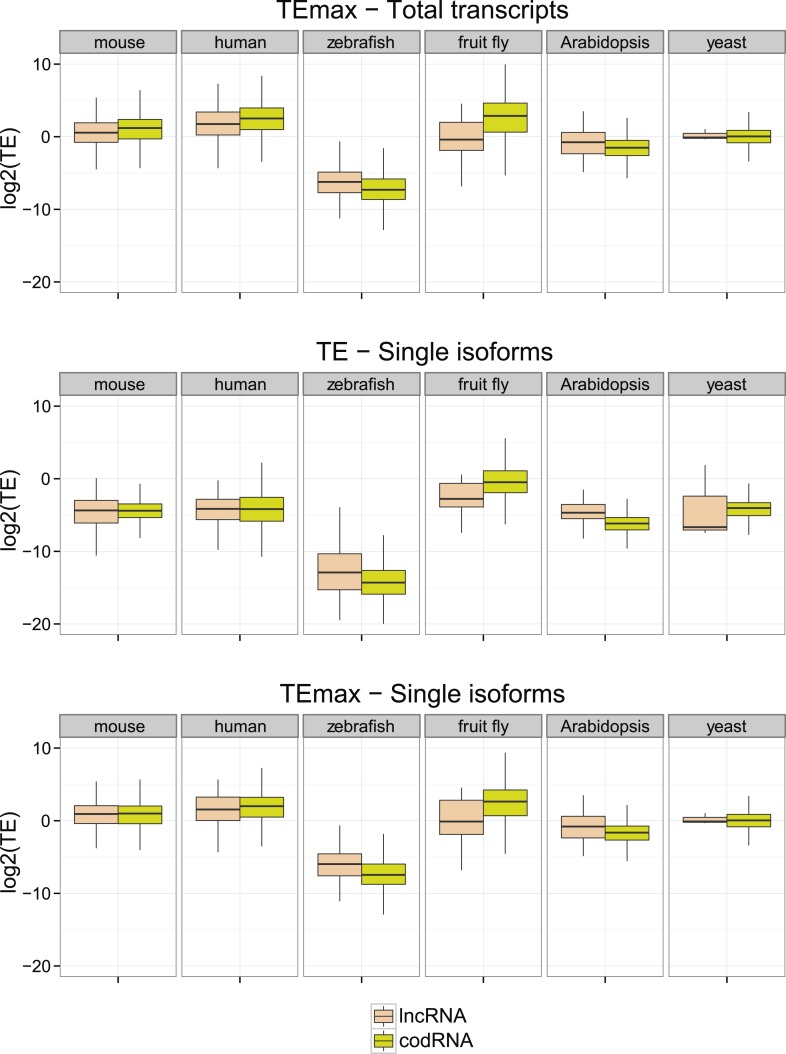
Additional translational efficiency (TE) measures.Single isoforms correspond to data for genes with a single transcript. The number of such genes was 2961 codRNA and 246 lncRNA_ribo for mouse, 2853 codRNA and 150 lncRNA_ribo for human, 9352 codRNA and 412 lncRNA_ribo for zebrafish, 836 codRNA and 18 lncRNA_ribo for fruit fly, and 3024 codRNA and 92 lncRNA_ribo for Arabidopsis. In the case of yeast, all genes were taken. TE max is the maximum TE value taking 90 nucleotide windows.